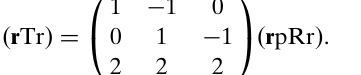
3D framework (Table 2). The shortest distances C—H (cid:3) (cid:3) (cid:3) Br (cid:2) are listed in Table 3. Also, the [dabcoH NH (cid:3) (cid:3) (cid:3) Br (cid:2) bonded to the linker anions, and these hydrogen